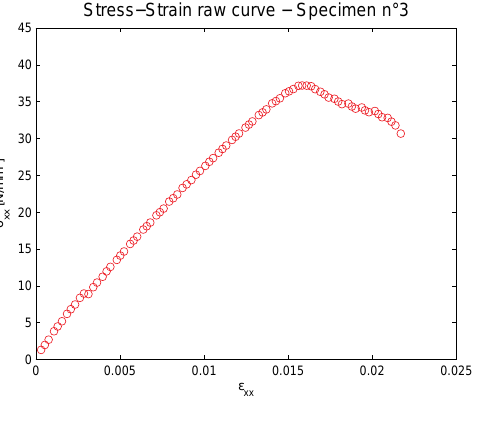
Figure 7: Raw stress-strain curve for specimens 3 and 4.